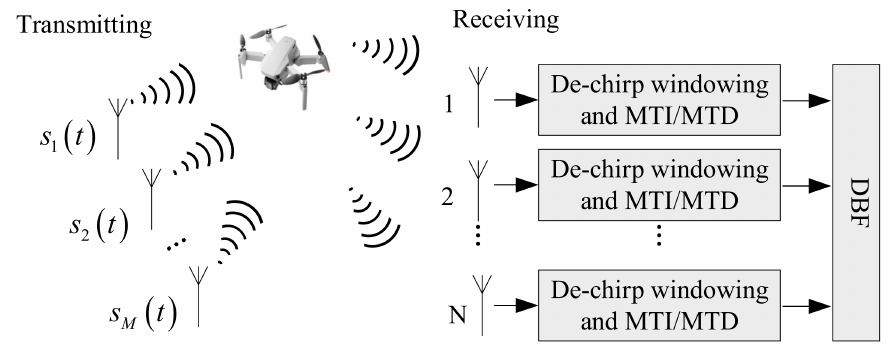
Figure 4. Improved time division MIMO radar signal processing